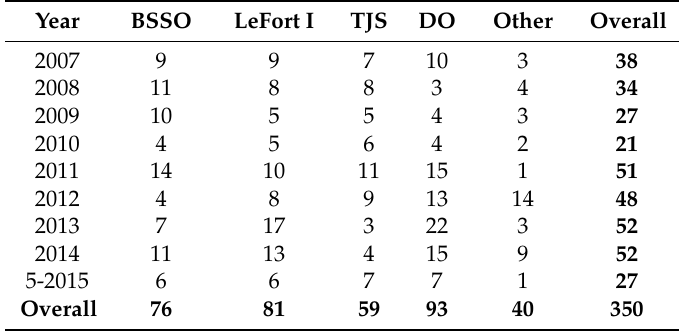
Table 1. Distribution of orthognathic procedures from January 2007 up to May 2015. Year BSSO LeFort I TJS DO Other Overall 2007